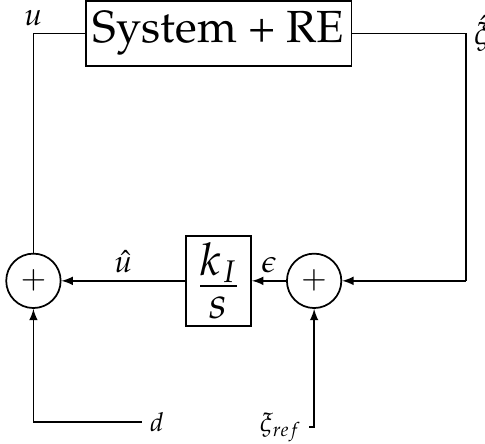
Figure 4. Extremum seeking as a simple output